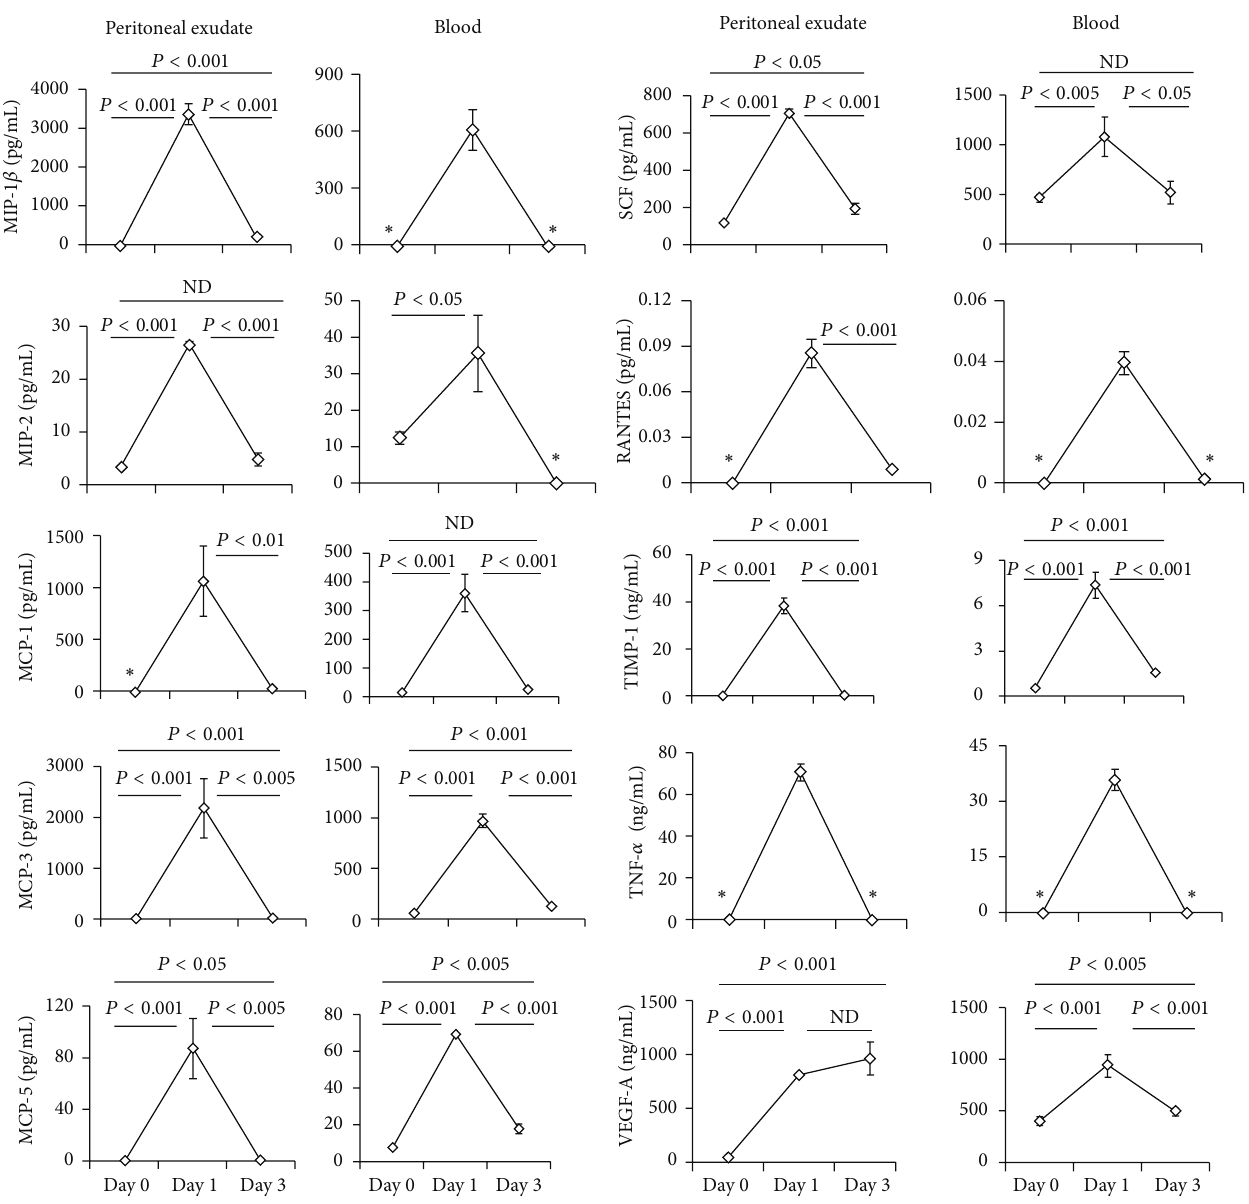
Figure 2: Concentration changes of 23 inflammatory mediators in peritoneal exudates and blood during thioglycollate treatment in vivo . C57BL/6 mice (males) were treated with thioglycollate as described in Section 2. At three timepoints, before (day 0) and after (day 1 and 3) the treatment, peritoneal exudates and plasma were isolated as described in Section 2. The concentrations of 23 inflammatory mediators were determined by a bead-based multiplexing immunoassay as described in Section 2. Values are represented as the means ± SE. 𝑛 = 3 –8 per timepoint. Data are from two independent experiments. ∗ Denotes that the mediator was undetectable at the indicated